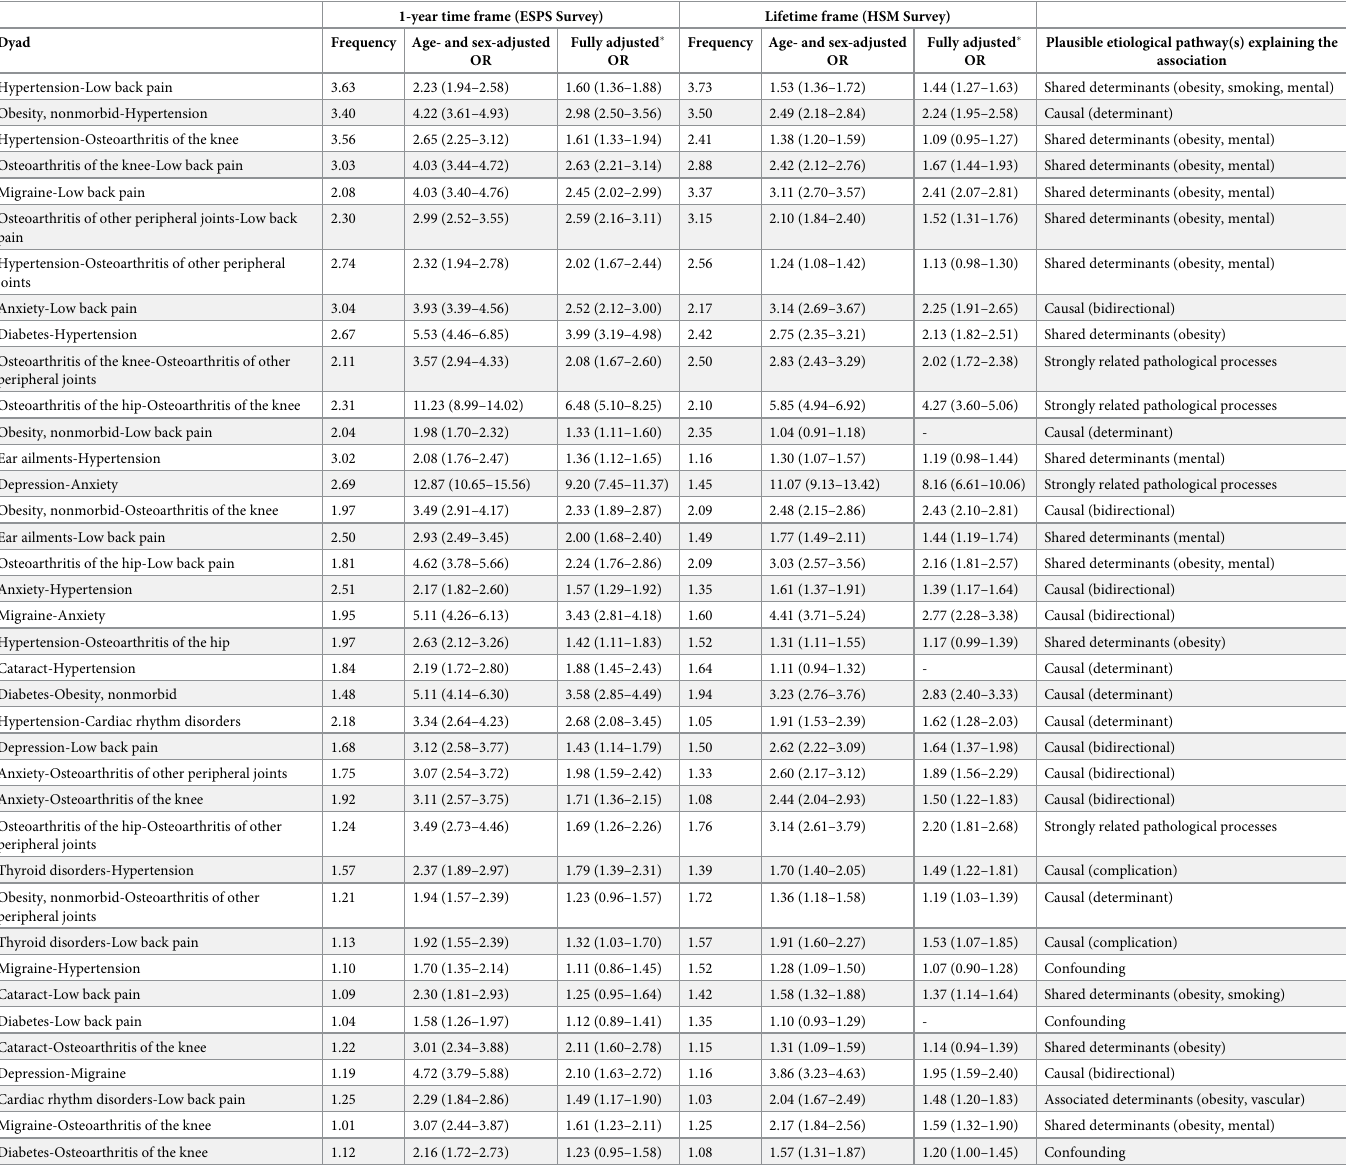
Table 3. Weighted frequency of dyads of conditions, strength of associations, and plausible etiological pathways explaining the associations. All dyads with a fre- quency of � 1% in both survey samples are considered. Dyads are presented in decreasing order of frequency (mean frequency based on the 2